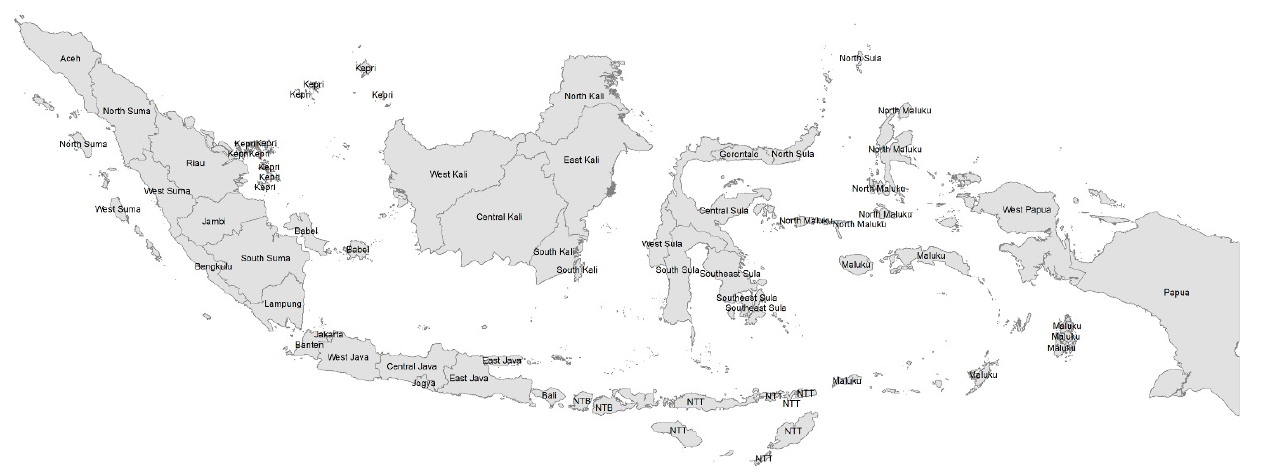
Figure A1. Map of Indonesia by province.